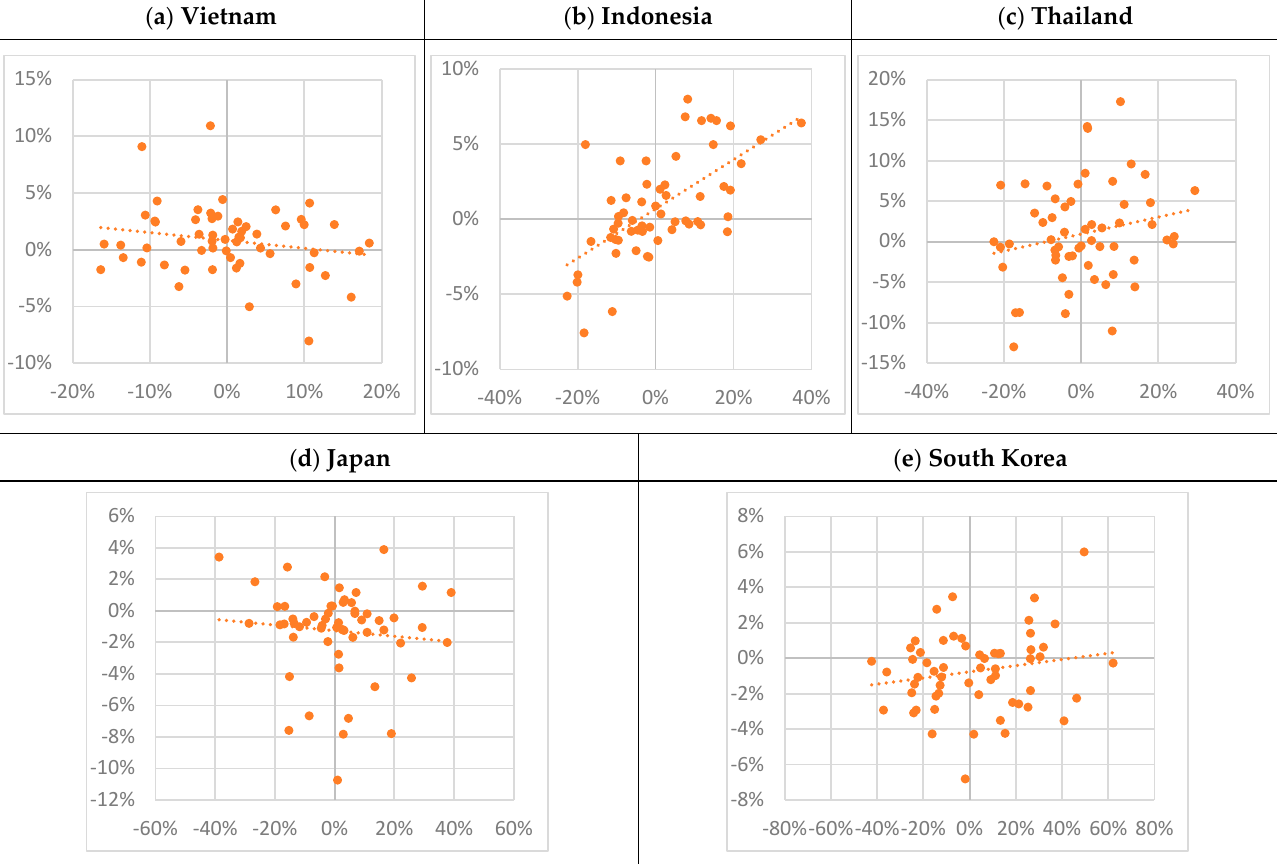
Figure 12. Relationship between changes in annual precipitation, and changes in annual area harvested of rice in ( a ) Vietnam, ( b ) Indonesia, ( c ) Thailand, ( d ) Japan, and ( e ) South Korea. These data range from 1961 to 2020. The X-axis represents the precipitation change (%), and the Y-axis represents the area harvested change (%). (Source: data retrieved from [4,84]).